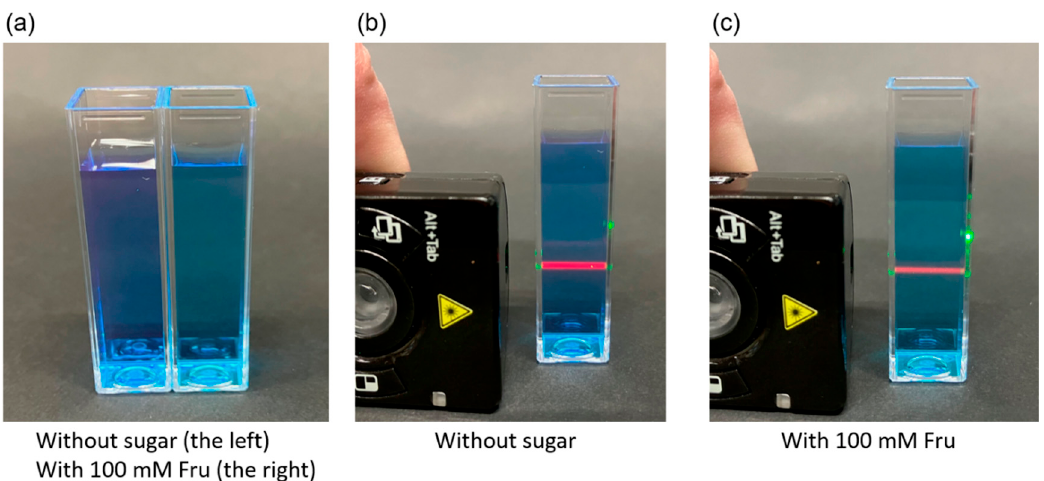
Figure 7. BRhoC solutions (17 μ M) in a 10 mM HEPES buffer at pH 7.4. ( a ) Under an ordinary fluorescent lamp without sugar ( left ) or with 100 mM Fru ( right ). ( b ) A solution without sugar irradiated by a 532 nm laser. ( c ) A solution with 100 mM Fru irradiated by a 532 nm laser. The binding constant ( K ) of the BRhoC–sugar complexes can be calculated using a curve-fitting analysis based on Equation (2) for the sugar-response curve (Figure 8) [16]: